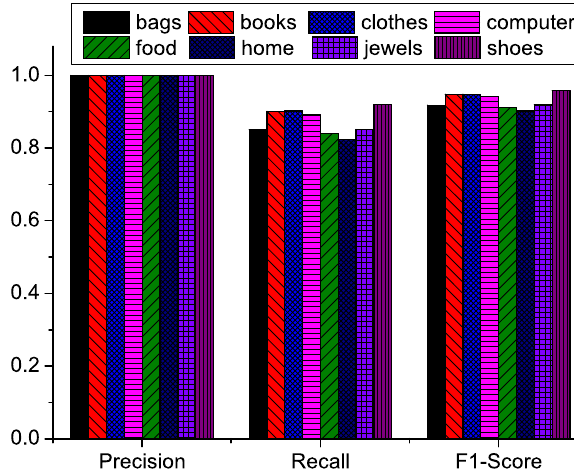
Fig. 9 F 1-Score comparison